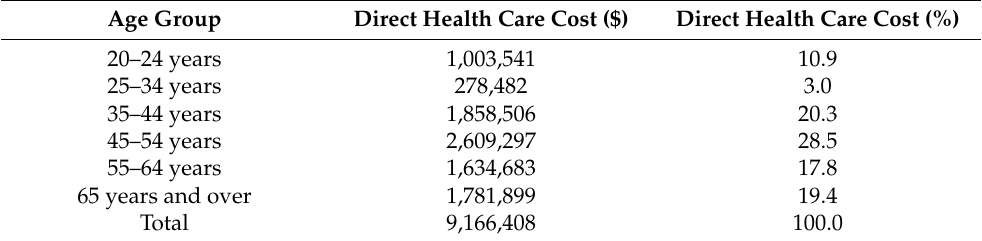
Table 4. Additional direct health care costs incurred due to LHL for those with a chronic condition (by age group) in the Blacktown LGA (Domain